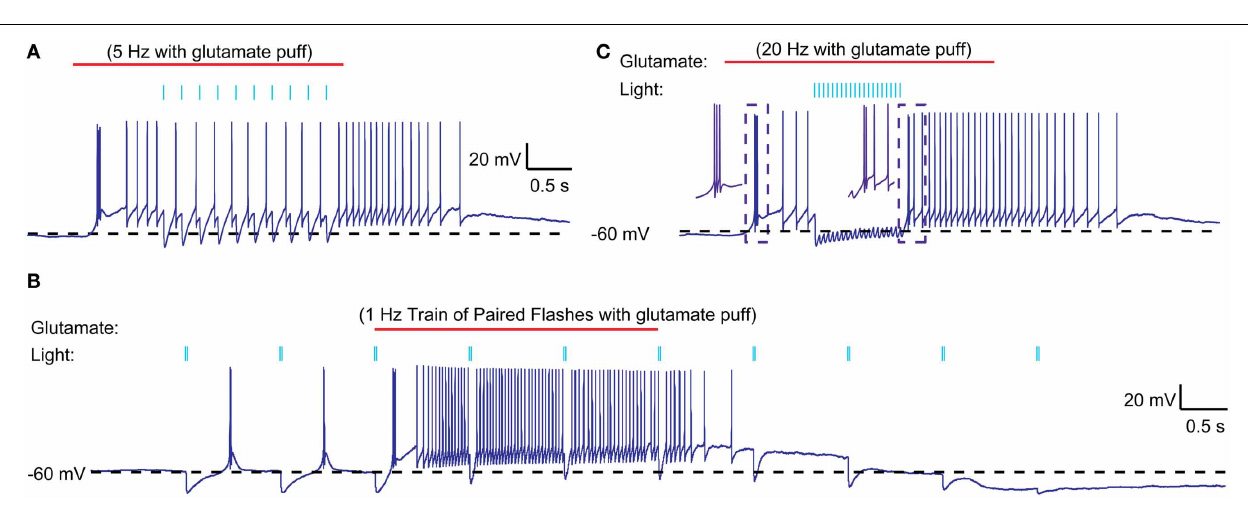
Paired light pulses (2ms pulse width, 20ms interval) before glutamate excitation can cause LTS rebound bursts (as shown in Figure 5 ), but the same paired pulses during glutamate excitation result in spike pauses only. (C) A 20Hz train of 5ms light pulses results in a prolonged pause during glutamate excitation and a weak LTS rebound burst (2 spikes)